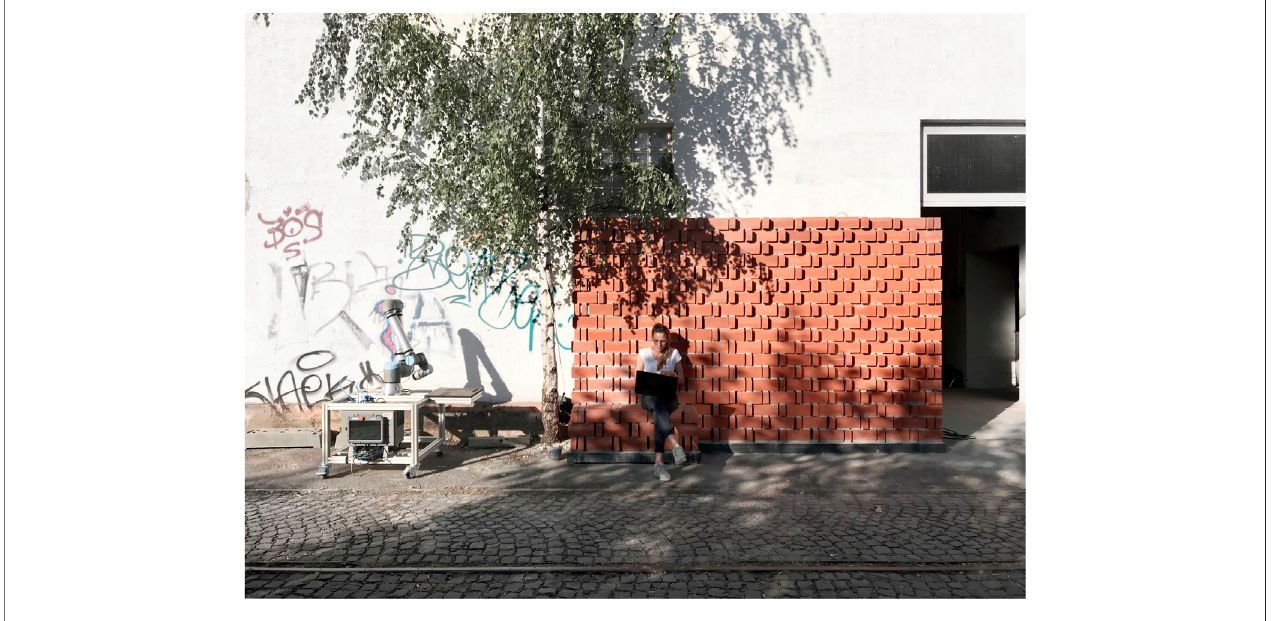
FIGURE 10 | Snapshot of the fabricated wall on 7 August 2020, in the early evening, 18:22.